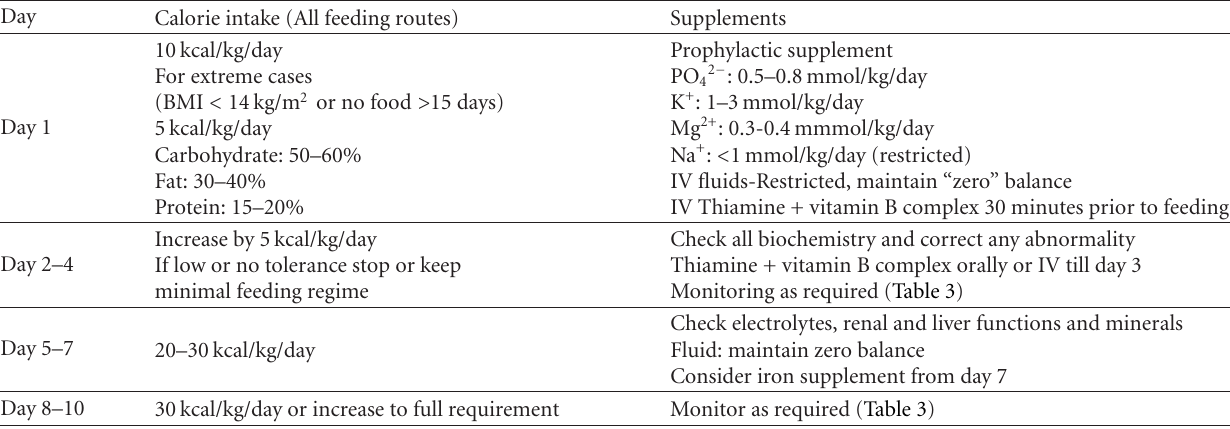
Table 4: Refeeding regime for patients at risk of RFS [5,